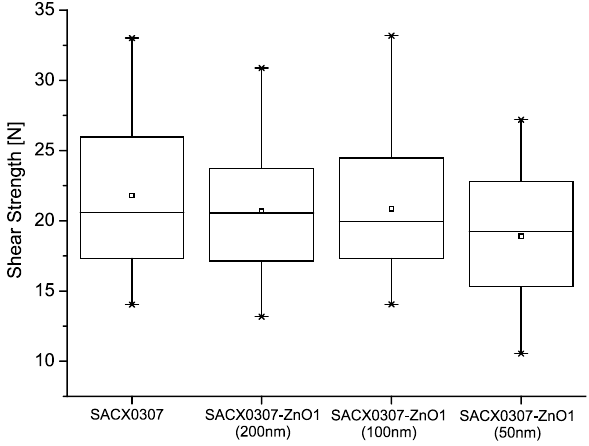
Figure 3. Shear strengths of the different solder joints.